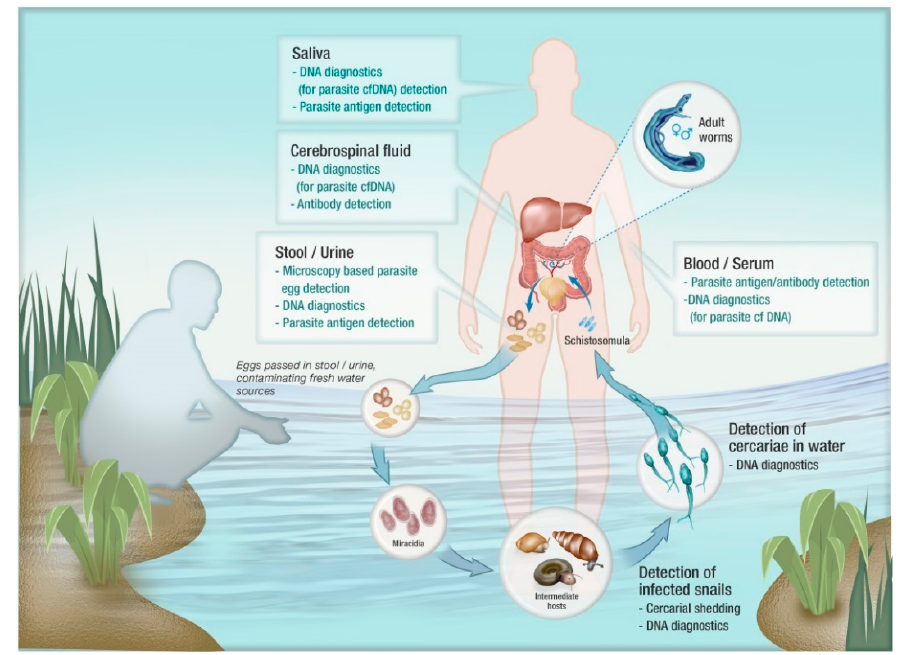
Figure 1. Applicability of diagnostic tools for the detection of different lifecycle stages of schistosomes.